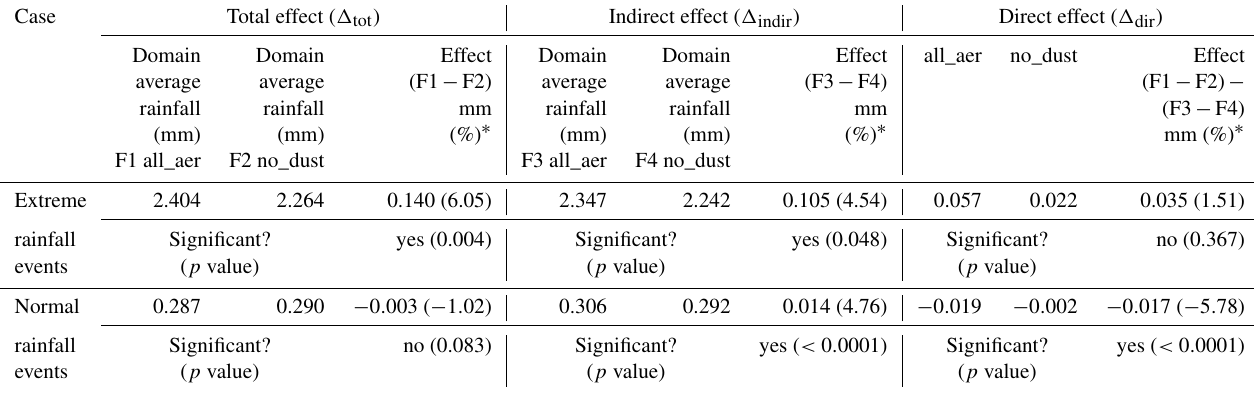
Table 3. Total, indirect, and direct effects of dust on rainfall for extreme and normal rainfall events.